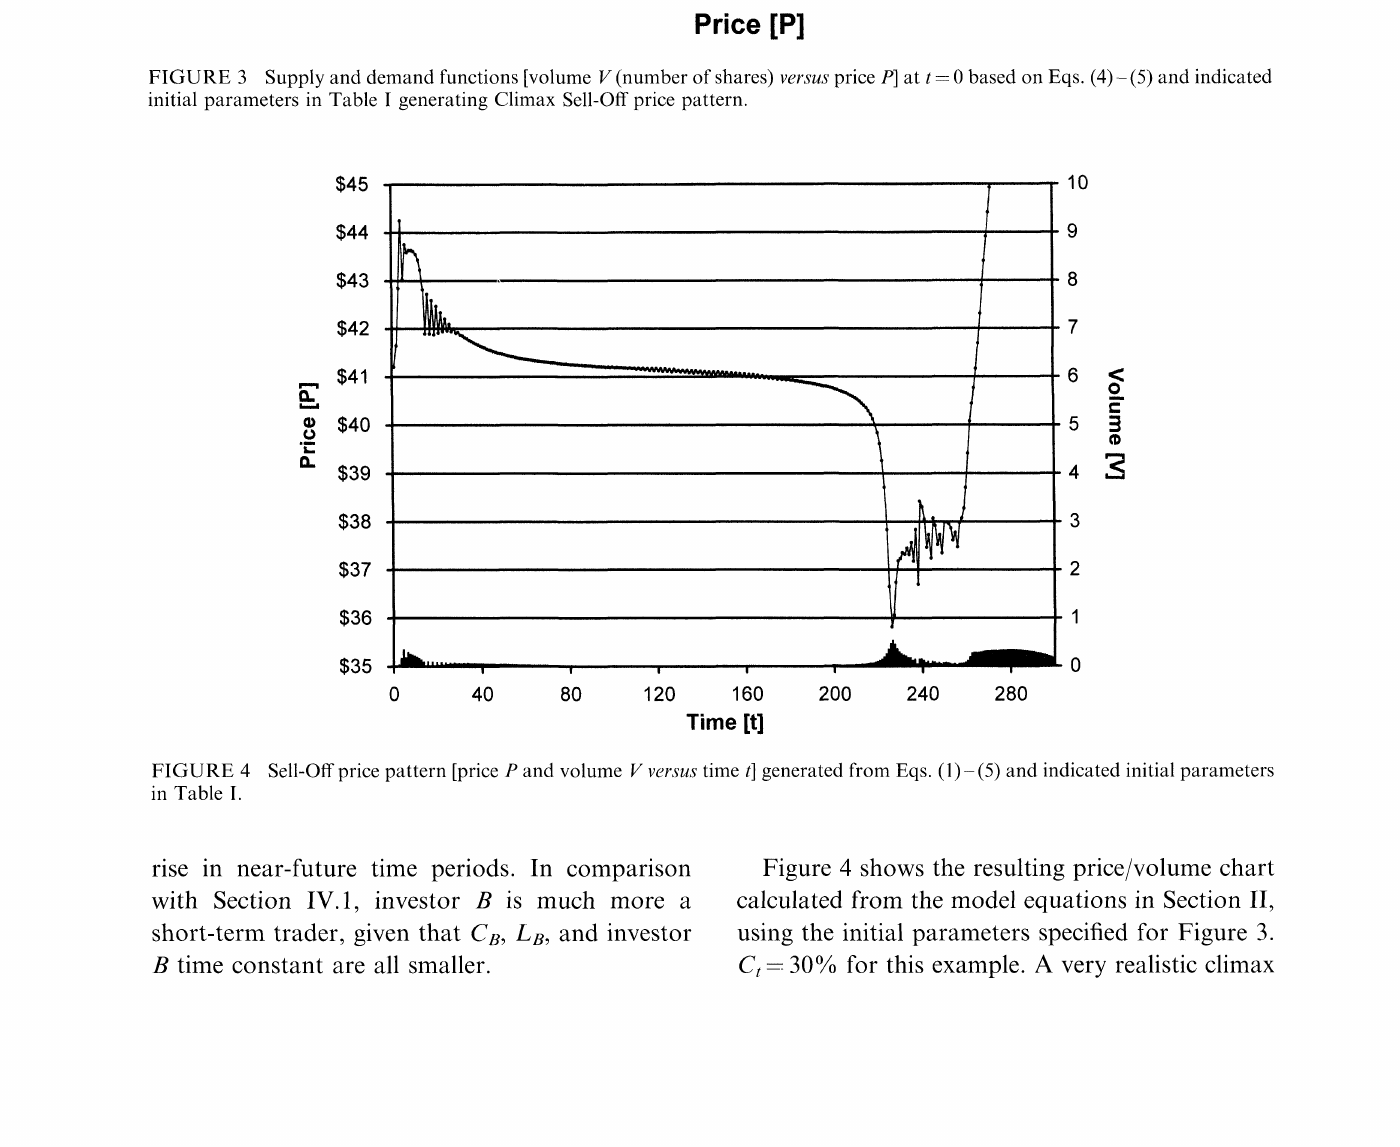
FIGURE 3 Supply and demand functions [volume V (number of shares) versus price P] at 0 based on Eqs. (4)-(5) and indicated initial parameters in Table generating Climax Sell-Off price pattern.